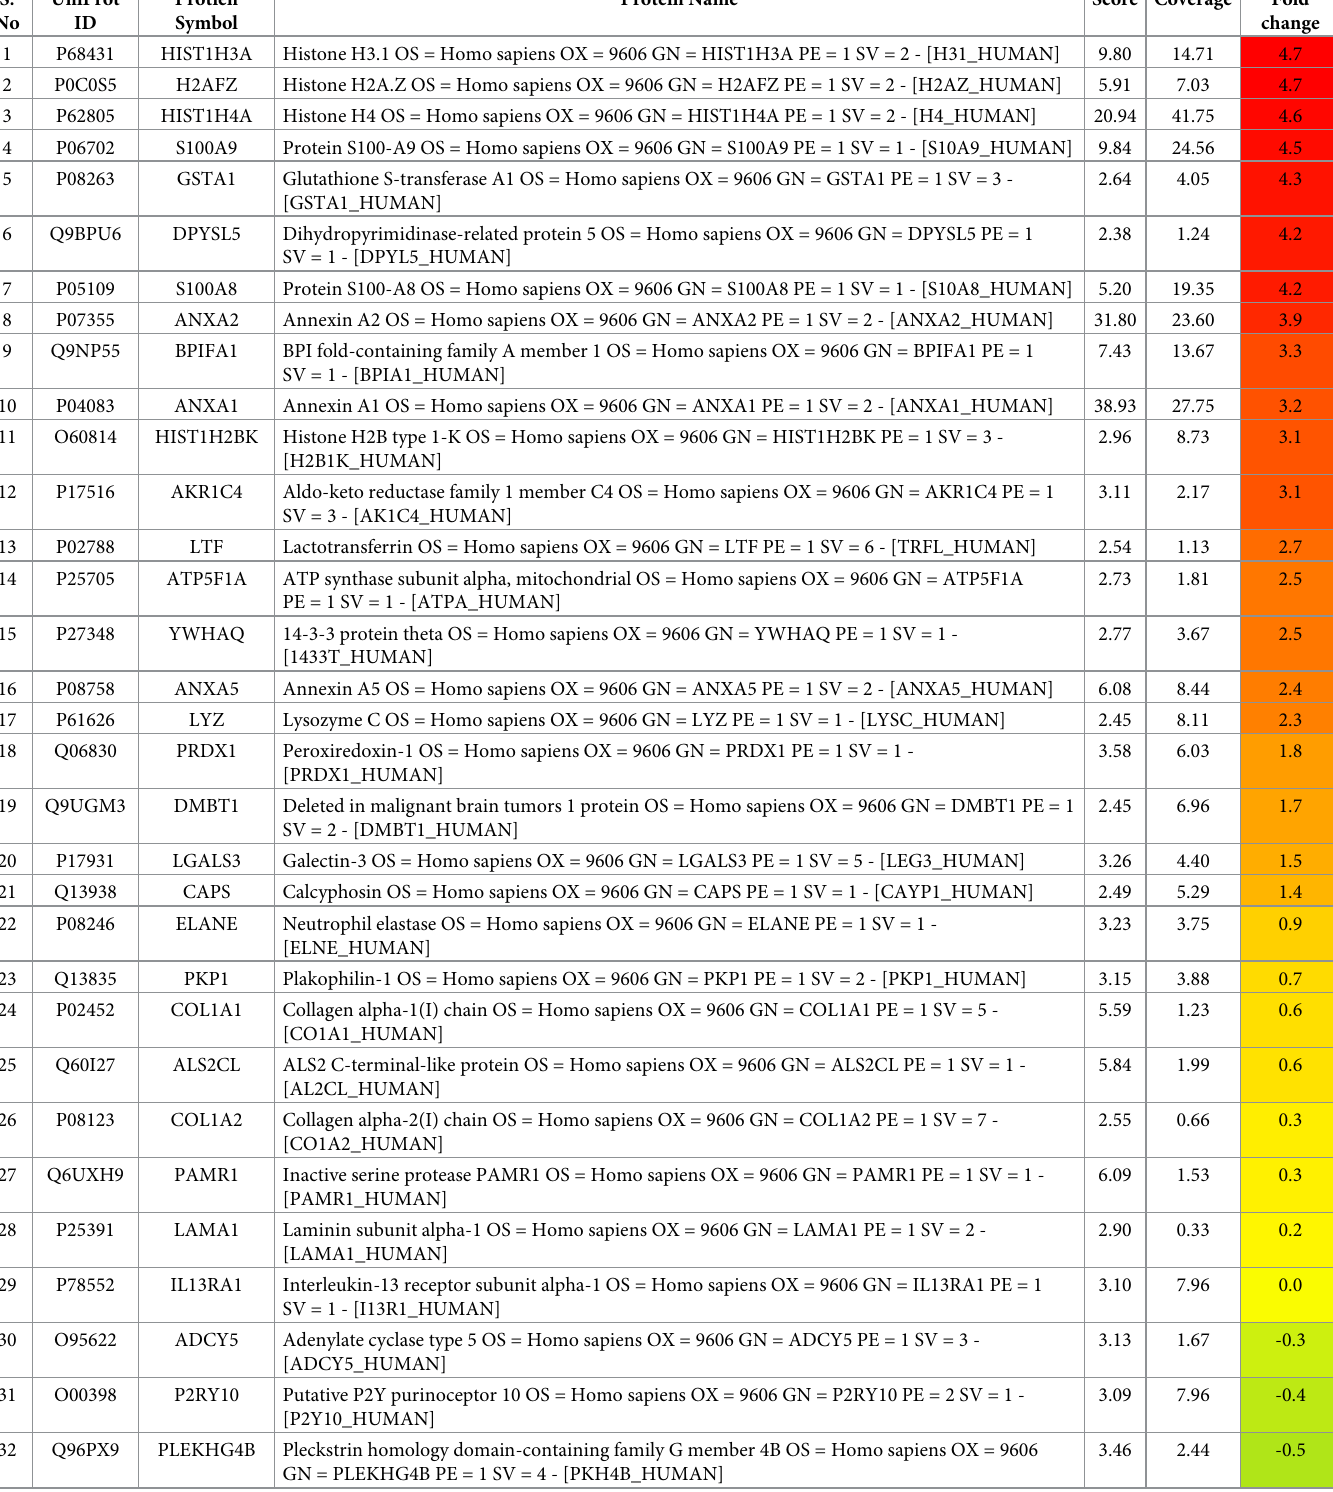
Table 2. List of proteins which were found differentially regulated in the infected NOPS samples against control negative samples. S. UniProt No